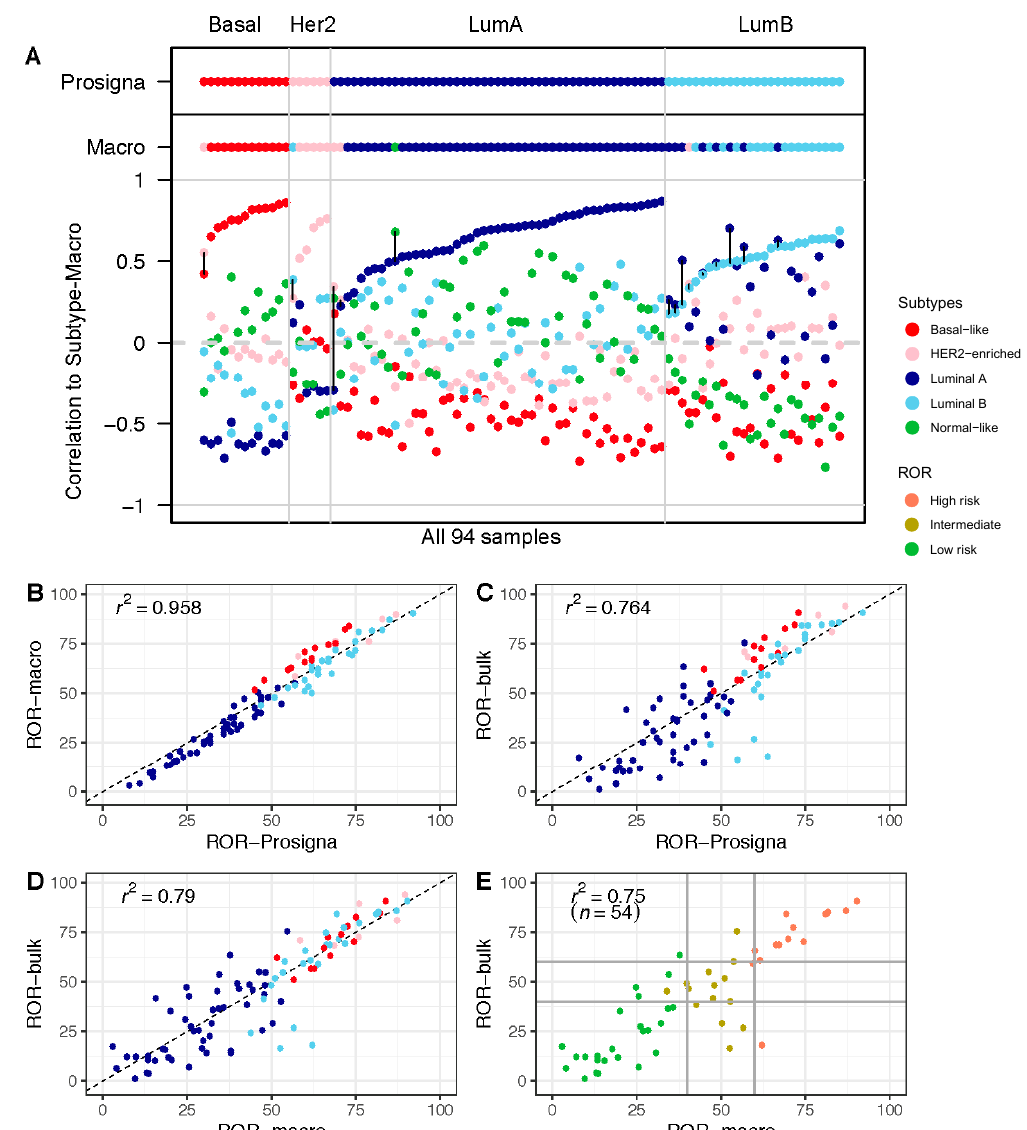
Figure 2. Risk of Recurrence (ROR) in macrodissected FFPE vs. FF bulk tumor tissue: ( A ) Correlation to each of the five PAM50 subtype centroids calculated based on the research-based Subtype-Macro from FFPE tumor tissue. PAM50 subtype calls from Subtype-Prosigna and Subtype-Macro are shown on top for comparison. Correlation coefficients on the y -axis, and the 94 breast tumor samples along the x -axis, are sorted by increasing correlation with Subtype-Prosigna. Discordant cases between Subtype-Prosigna and Subtype-Macro are marked with black vertical lines. Samples are colored according to subtype (red = basal-like; pink = HER2-enriched; dark blue = luminal A; light blue = luminal B; green = normal-like). ( B ) ROR-Prosigna plotted against ROR-Macro for all 94 patients. ( C ) ROR-Prosigna plotted against ROR-Bulk for all 94 patients. ( D ) ROR-Macro plotted against ROR-Bulk for all 94 patients. ( E ) ROR-Macro plotted against ROR-Bulk for the subgroup of 54 node-negative, ER+, and HER2 − breast tumors eligible for the Prosigna test. In panels ( B – D ), samples are color-coded by subtype according to Subtype-Prosigna, and in panel ( E ) by ROR-Prosigna (red = high risk; brown = intermediate risk; green = low risk). Horizontal and vertical lines indicate the clinically used thresholds for ROR.